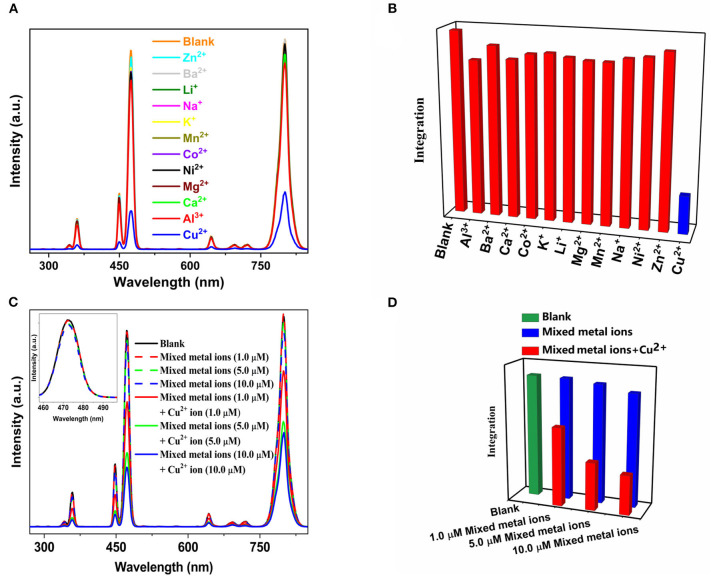
(A) The effect of various equimolar metal ions i.e., Al3+, Ba2+, Ca2+, Co2+, K+, Li+, Mg2+, Mn2+, Na+, Ni2+, Zn2+, and Cu2+ (2 μM) on the upconversion emission intensity of PAA-NaYb0.5Nd0.5F4@NaYb0.5Gd0.49Tm0.01F4@NaGdF4 UCNPs under 980 nm laser excitation; (B) graphical representation of (A); (C) comparison of upconversion emission intensity of PAA-NaYb0.5Nd0.5F4@NaYb0.5Gd0.49Tm0.01F4@NaGdF4 UCNPs upon addition of mixed metals ions with and without Cu2+ ions under 980 nm laser excitation and (D) graphical representation of (C).